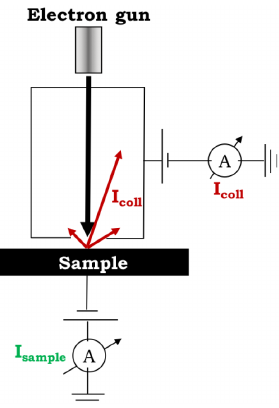
FIG. 10. Profile of C, O, Ti, V, Zr, and Cu as a function of depth for all the samples. FIG. 11. SEY measurements